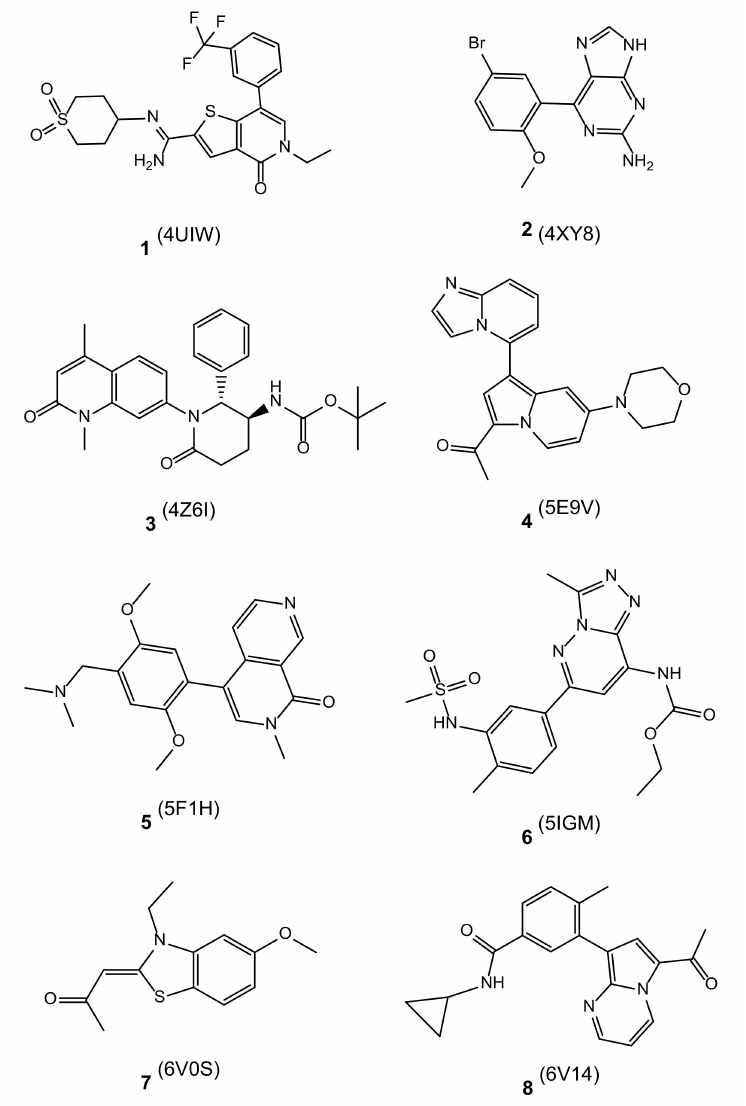
Figure 3. Molecular structure of the co-crystallized ligands 1 – 8 for each complex. The original PDB code related to the specific ligand is reported in